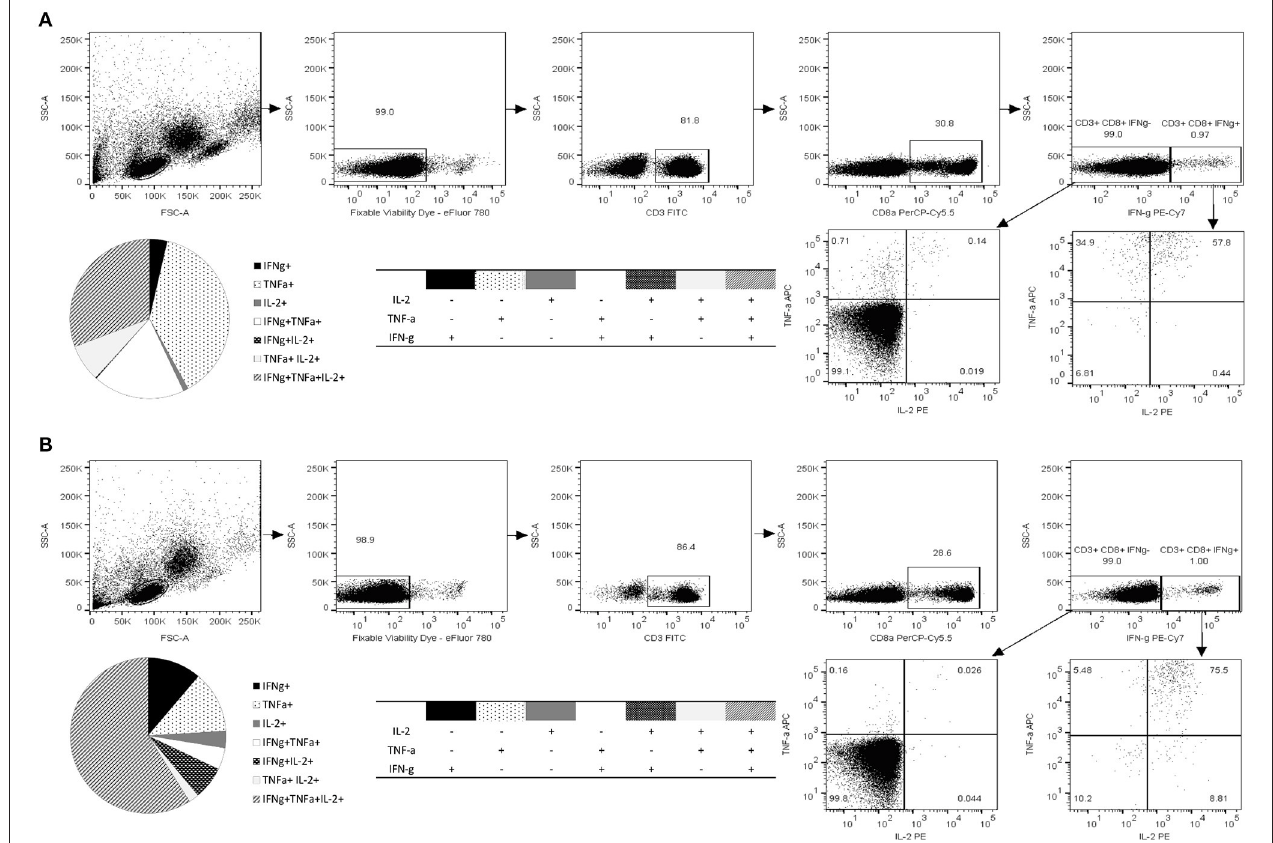
FIGURE 4 | Functional characterization of norovirus 10-mer epitope 139 TMFPHIIVDV 148 –specific CD8 + T cells by intracellular cytokine staining (ICS). Production of IL-2, IFN- γ , and TNF- α measured by ICS after 16h stimulation of the PBMC with the peptide 139 TMFPHIIVDV 148 (4 µ g/ml). Shown are the results of the two HLA-A * 0201-positive donors, Donor 1 (A) and Donor 2 (B) . Live epitope-specific CD3 + CD8 + T cells were segregated into IFN- γ + and IFN- γ − T cells. Seven distinct populations, based on production of the cytokines in any combination are depicted on the pie charts and the accompanying tables. Fractions of the cells